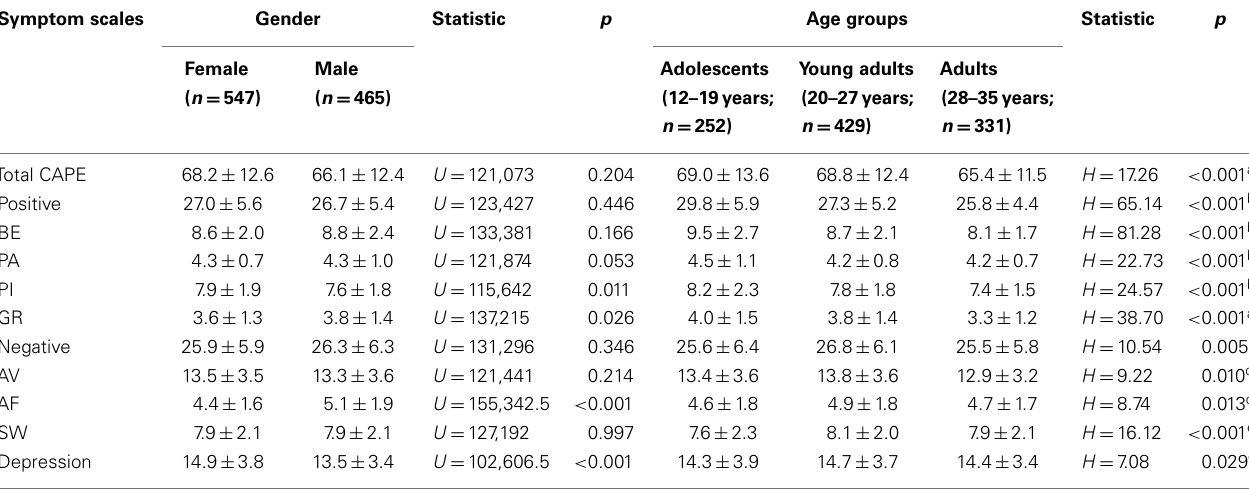
Table 4 | Community assessment of psychic experiences (CAPE) scores divided by gender and age group . Symptom scales